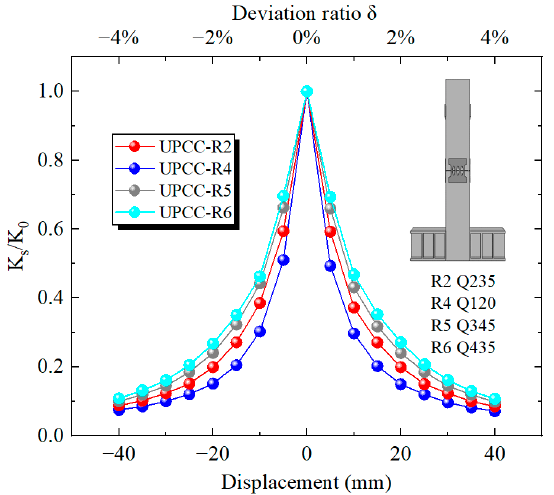
Figure 28. Degradation stiffness under different steel yield strength of EREDL.